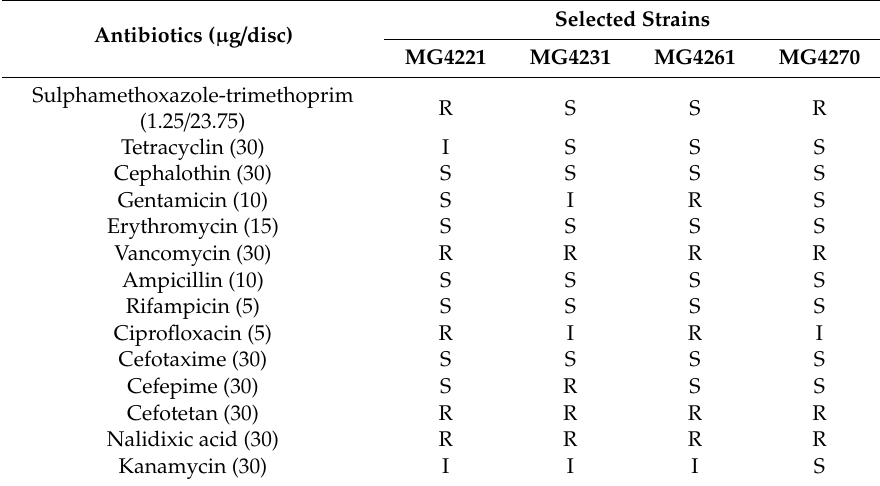
Table 2. Antibiotic sensitivity and resistance of selected